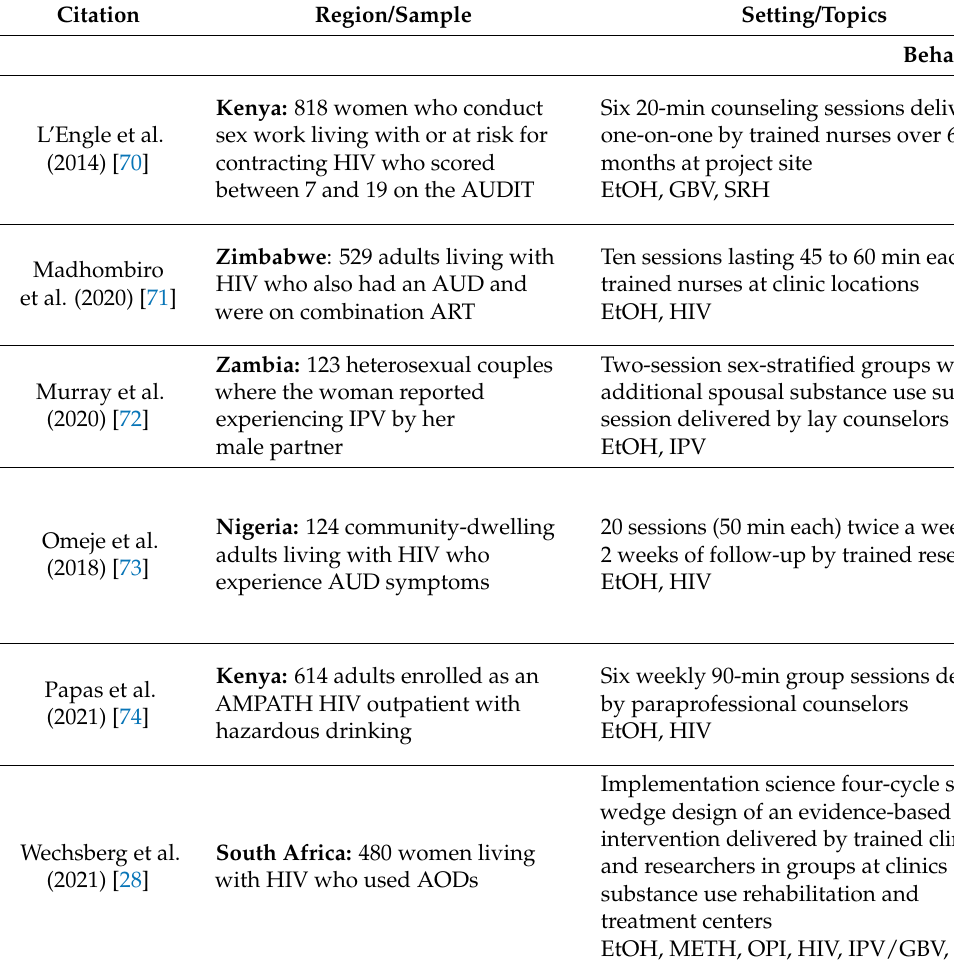
Table 1. Comprehensive interventions targeting individuals who use alcohol and other